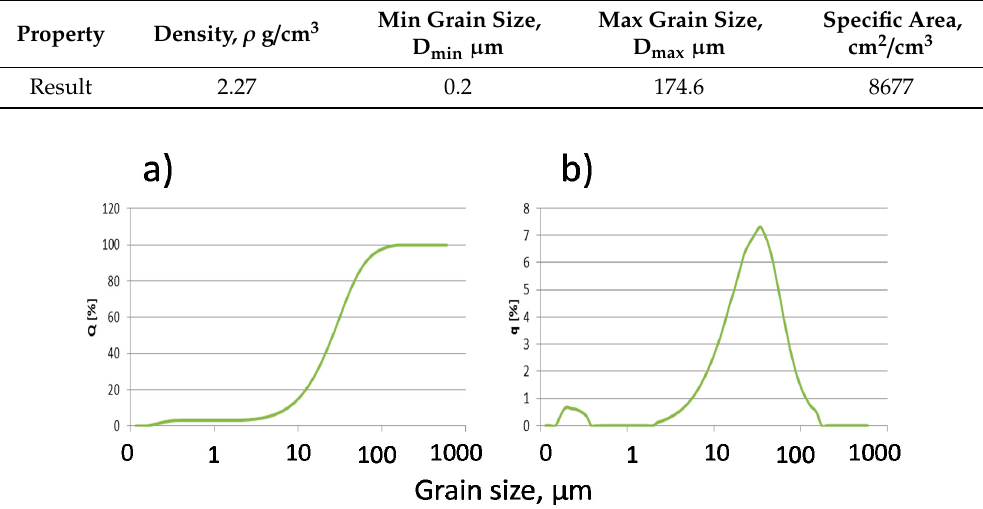
Table 2. Basic properties of calcareous fly ash used in research.